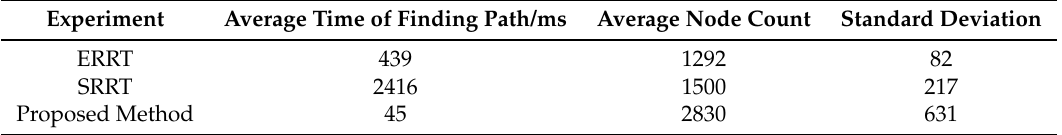
Table 2. Simulation comparison result of three